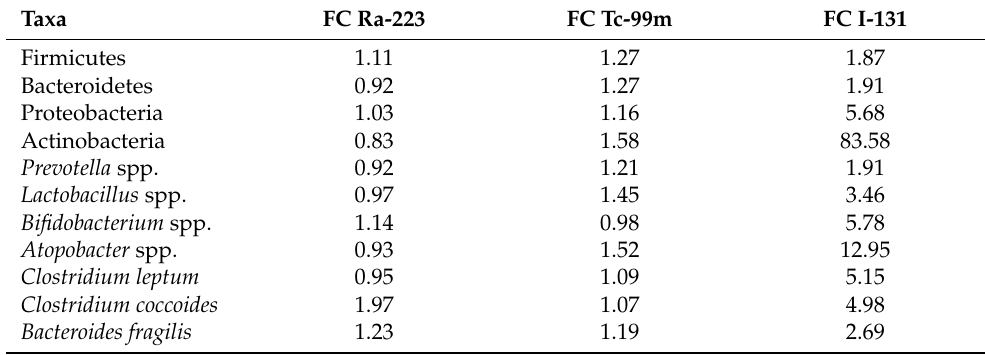
Table 2. The fold change (FC) ‐ 2^( −∆∆ CT) ‐ of the samples mixed with the radiopharmaceuticals, compared with the non irradiated control samples, normalized for the reference gene.